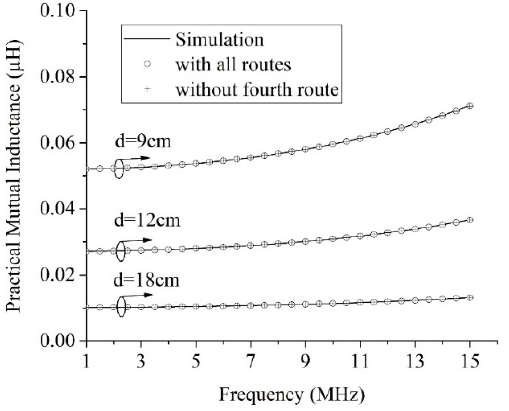
Figure 12. Simulated and calculated results for the array of four coils.